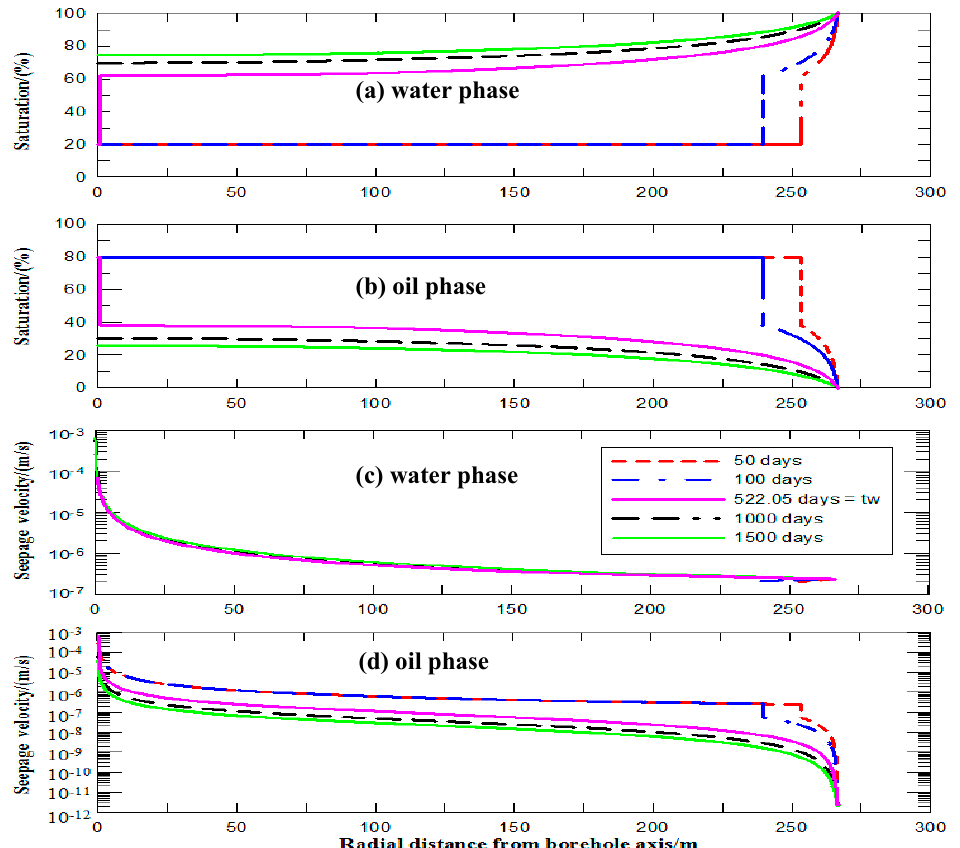
Figure 10. Water phase seepage characteristics for pay zones of oil–water two-phase flow with different production time: ( a ) water saturation; ( b ) oil saturation; ( c ) radial seepage velocity of water phase; ( d ) radial seepage velocity of the oil phase.